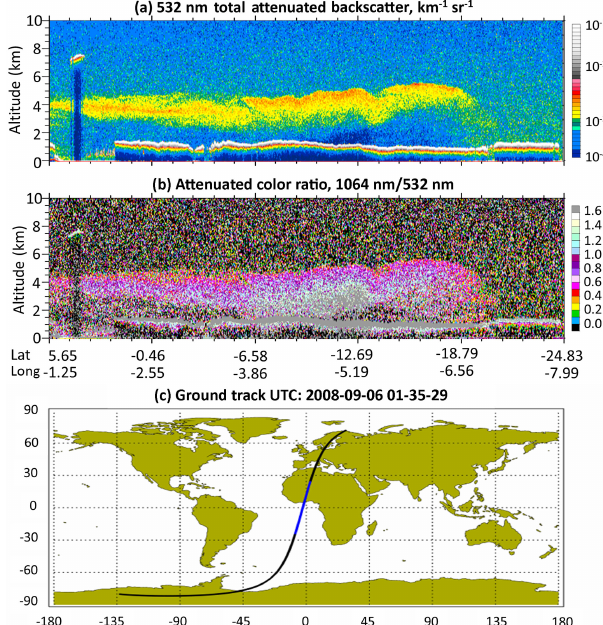
Figure 8. (a) Total attenuated backscatter and (b) 1064nm / 532nm attenuated color ratio and (c) the ground track on 6 September 2008 showing an extended smoke plume lying over a stratus cloud deck off the west coast of central Africa.